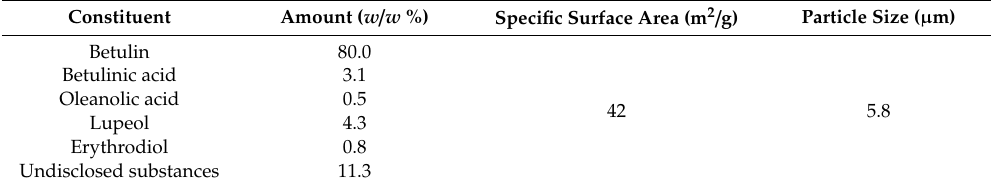
Table 1. Chemical and physical characteristics of the birch bark dry